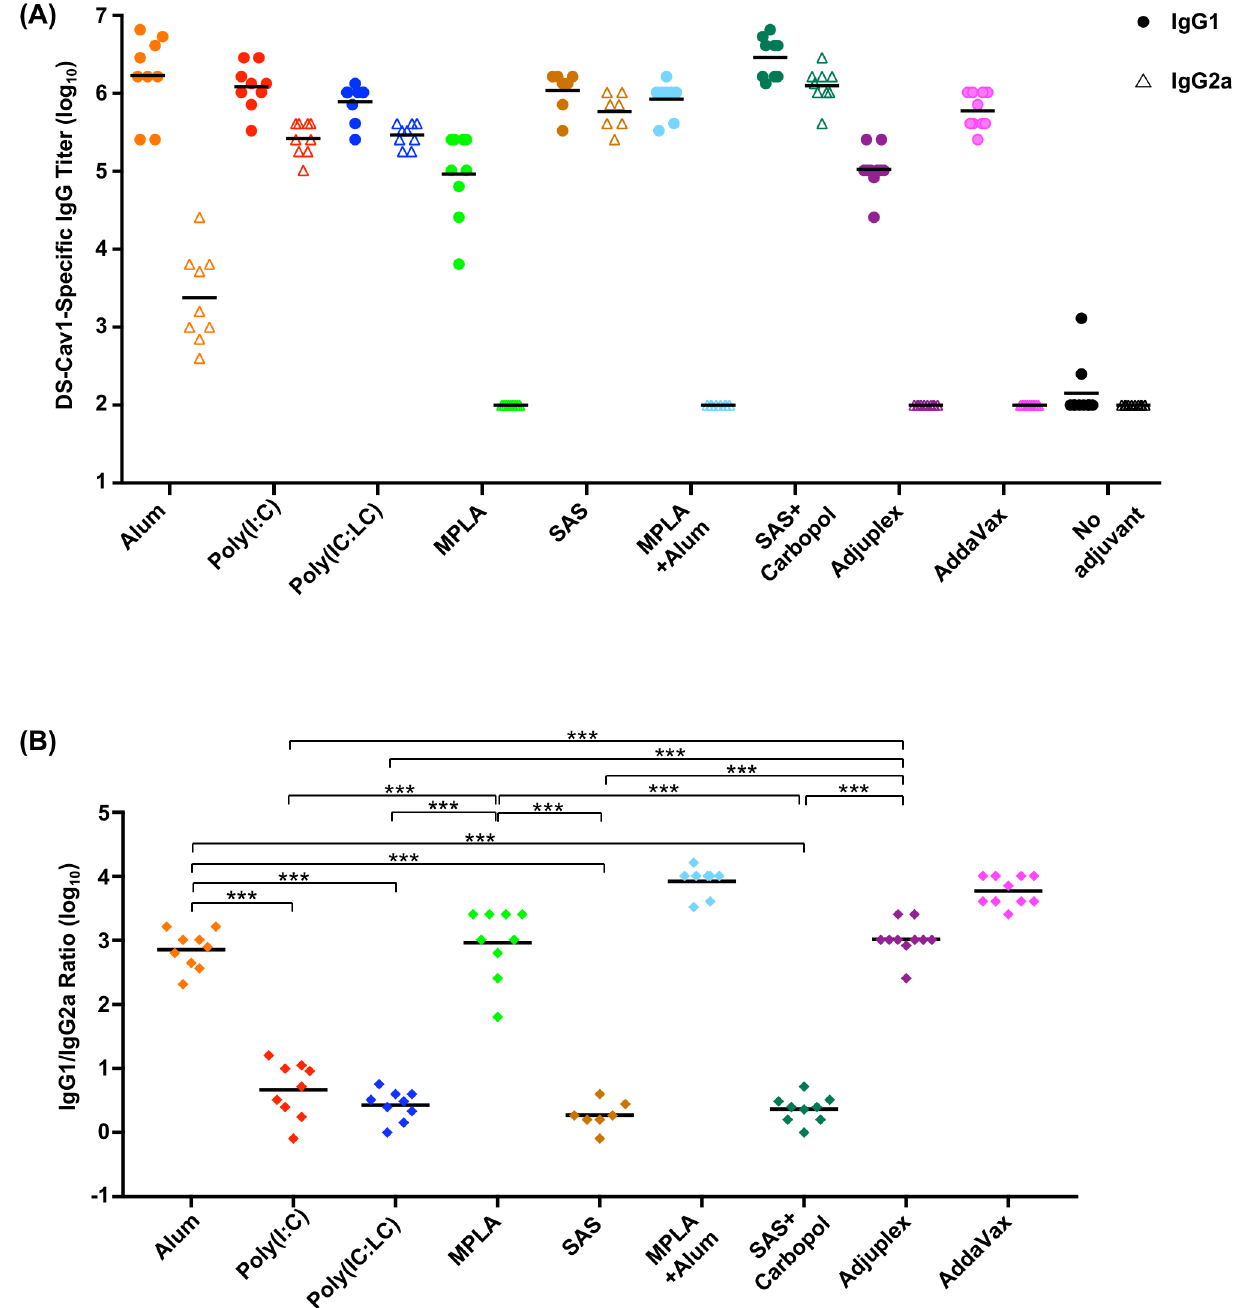
Fig 3. DS-Cav1-adjuvant formulations elicit antibodies of different IgG subclass in immunized mice. (A) Sera from na ï vemice primed and boostedwith DS-Cav1 adjuvant mixtures were assayed by ELISA for their RSV F DS-Cav1 specific IgG1 and IgG2a antibody responses. Scatter plots show the geometric mean, closed circles and open trianglesrepresentIgG1 and IgG2a antibody titers, respectively.(B) The ratios of IgG1 to IgG2a for each animalin the adjuvanted groups were calculatedfrom the upper panel. p -values were determined using a two- tailed Mann-Whitney test and were adjustedfor multiple comparisons using the Holm-Bonferroni method, p < 0.001 ( *** ). Associatedraw data is listed in S3 Table.